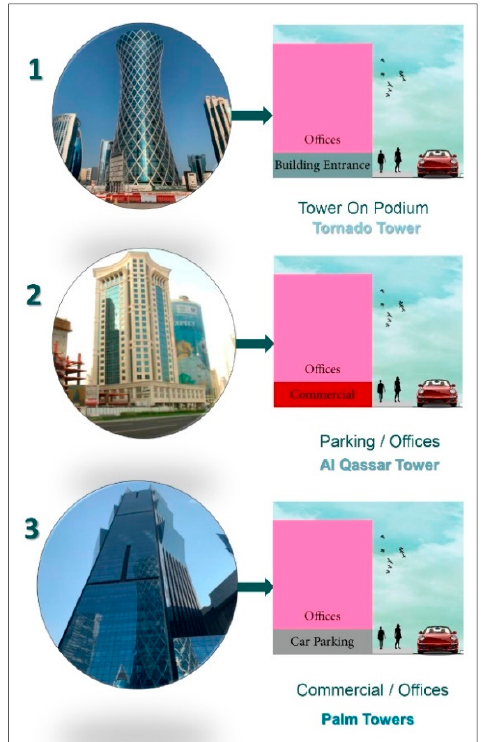
Figure 11. Different tower prototypes (Source: the Authors).